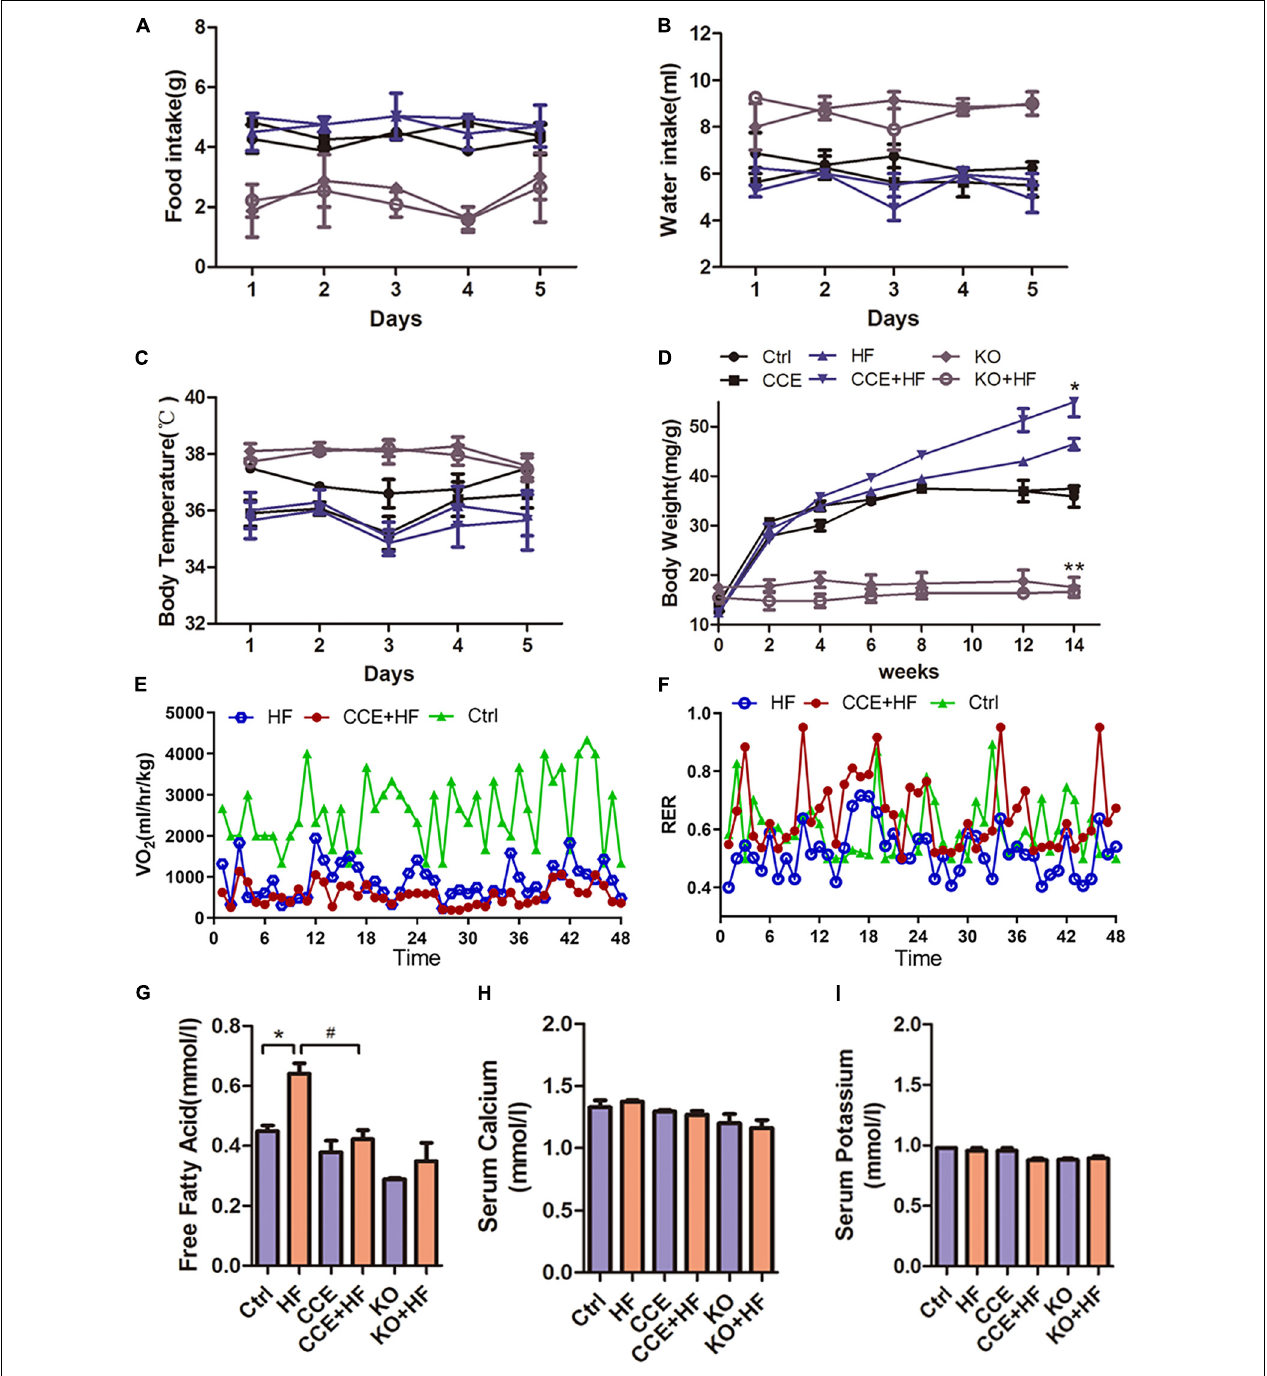
FIGURE 2 | Effect of vitamin D on energy metabolism in mice fed a high-fat diet. (A) Body weight changes in control or KO mice receiving CCE or a high-fat diet for 14 weeks (* p < 0.05 or ** p < 0.01). (B) Food intake, (C) water intake, and (D) body temperature in each group were monitored for 5 days, and no changes were observed in all groups ( p > 0.05). (E) O 2 consumption and (F) respiratory exchange rate indicated a lower metabolic rate in the CCE + HF group than in the HF group. Serum lipid levels analysis: (G) free fatty acids, (H) serum calcium, and (I) serum potassium, with relative changes shown for all groups (* p < 0.05 vs. Ctrl, # p < 0.05 vs. HF). Values are expressed as the mean ± SEM. Ctrl, control group. CCE, Fed cholecalciferol cholesterol emulsion [a precursor of 1, 25(OH)2D3] group. HF, Fed high fat die group. CCE + HF, Fed cholecalciferol cholesterol emulsion [a precursor of 1, 25(OH)2D3] and high fat die group. KO, Cyp27b1 − / − mice, KO + HF, Cyp27b1 − / − mice fed with high fat die